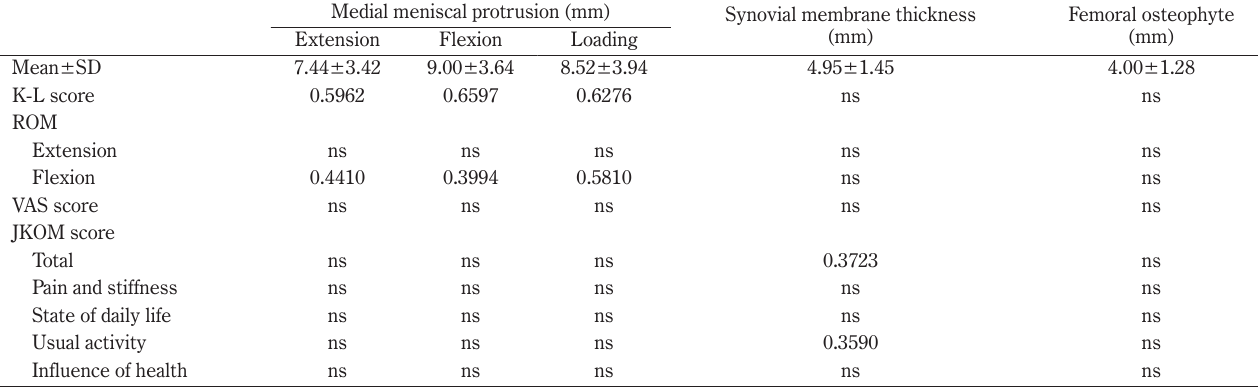
Figure 2 Transverse plane with the echo probe in contact with the proximal aspect of the patella. (a) Synovial membrane thickness. (b) Perpendicular line of the central femoral bone. (c) Cartilage surface. (d) Synovial surface. (e) Proximal aspect of the patella. Table 2 Correlations ( ρ ) between US findings and K-L score, ROM, VAS score, and JKOM